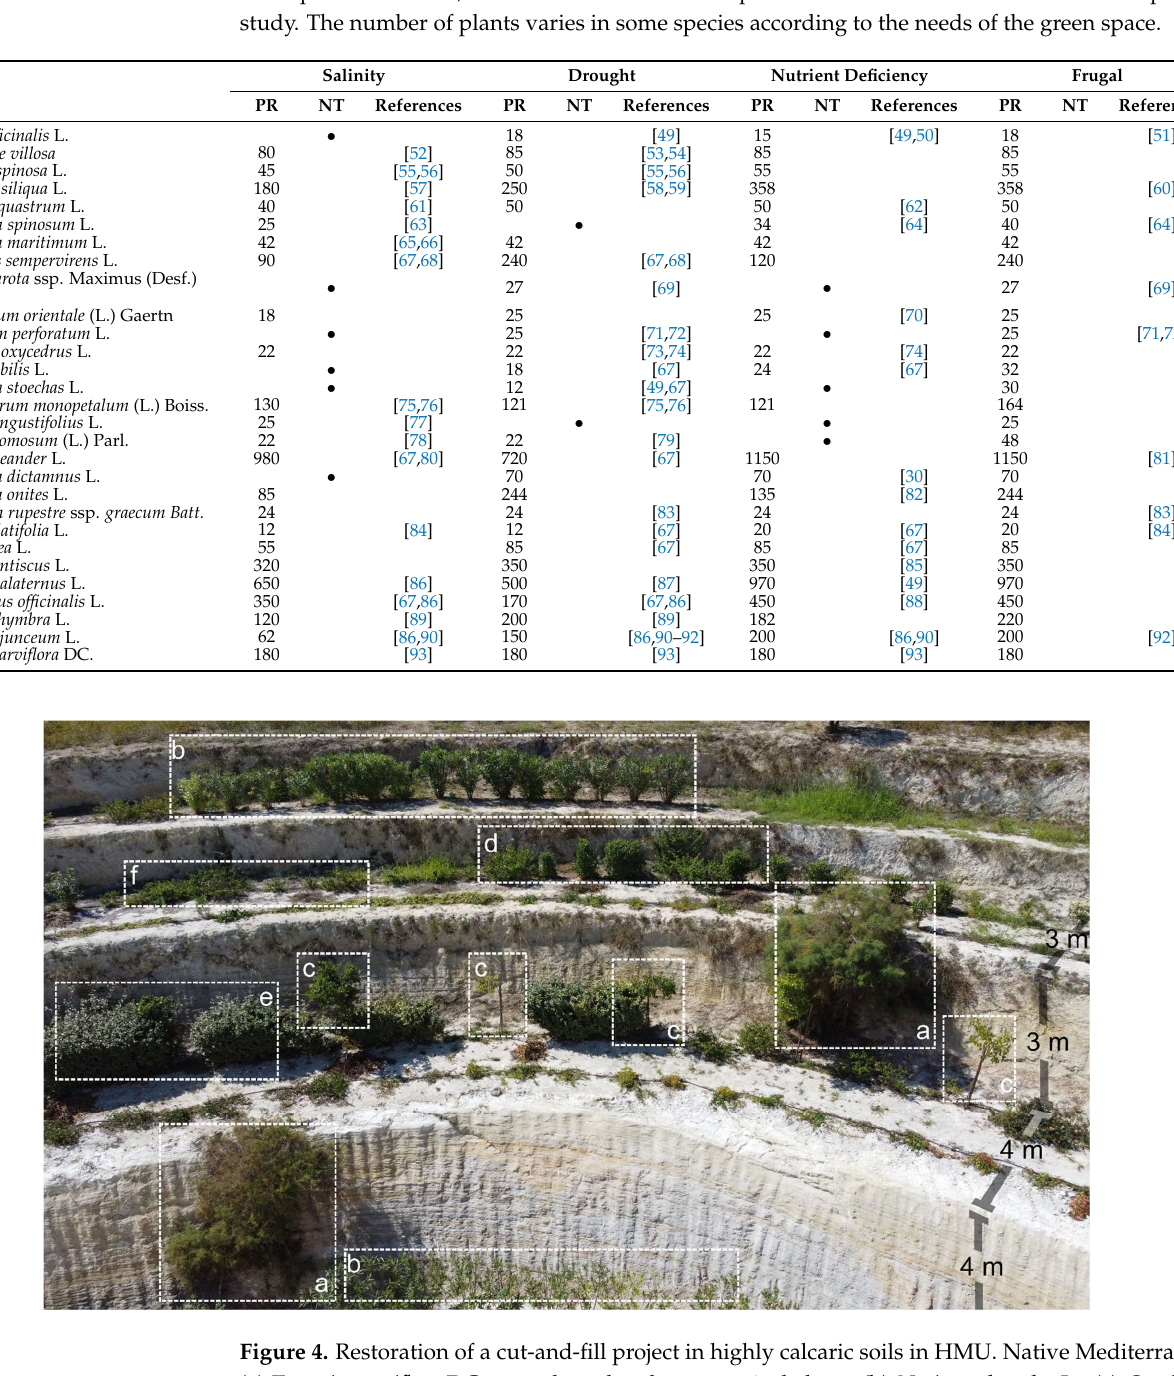
Figure 4. Restoration of a cut-and-fill project in highly calcaric soils in HMU. Native Mediterranean (a) Tamarix parviflora DC. rooted on the almost vertical slope, (b) Nerium oleander L., (c) Cercis sili- quastrum L., (d) Viburnum tinus L., and alien e) Elaeagnus pungens C. P. Thunb. Ex A. Murray and (f) Lantana camara L. can be distinguished. Scale on the right is approximate. Photo: I. Daliakopoulos.